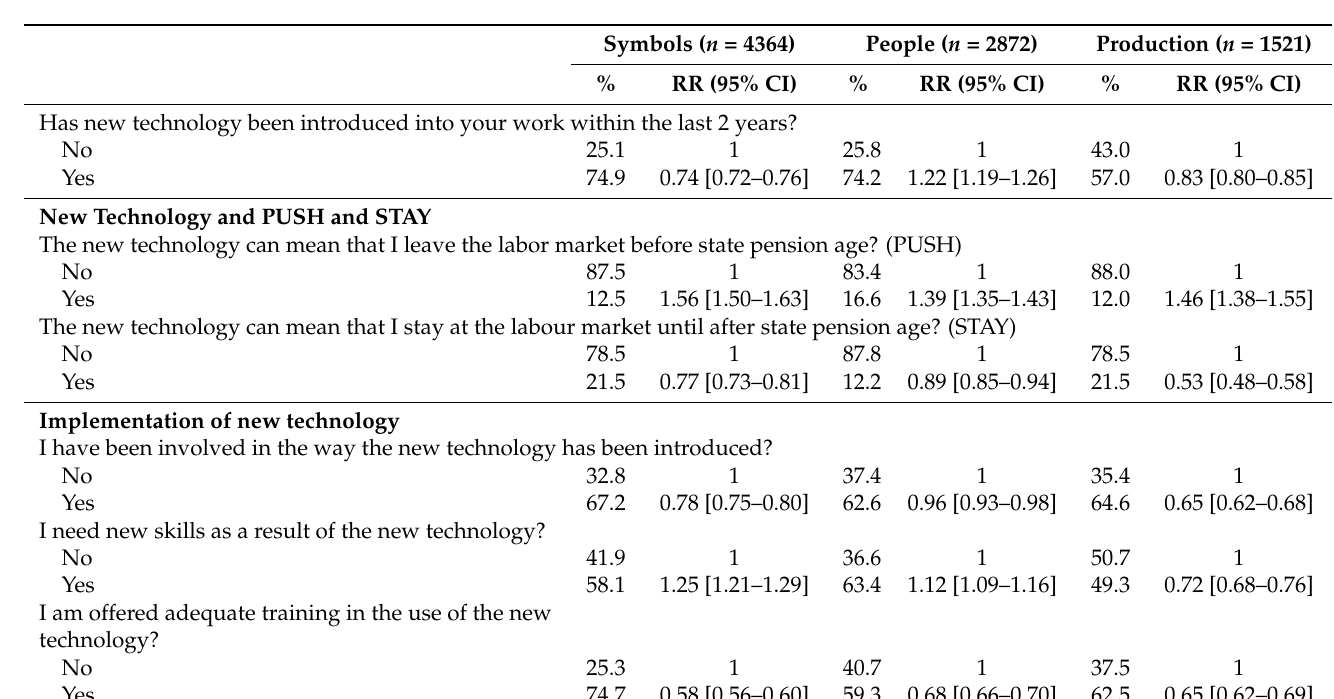
Table 3. Association between new technology at work and loss of paid employment stratified by job function category: work with symbols, work with people, work in the field of production. RR = risk ratio, CI = confidence